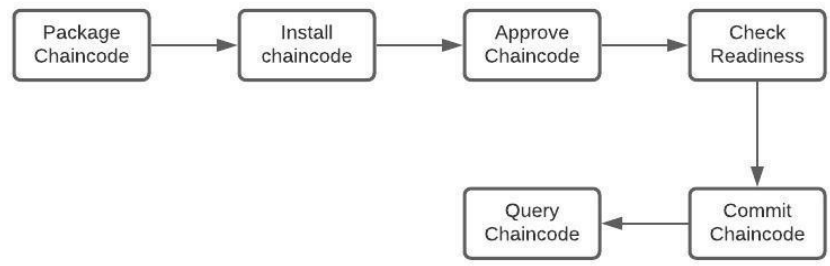
Figure 5. Chaincode lifecycle.